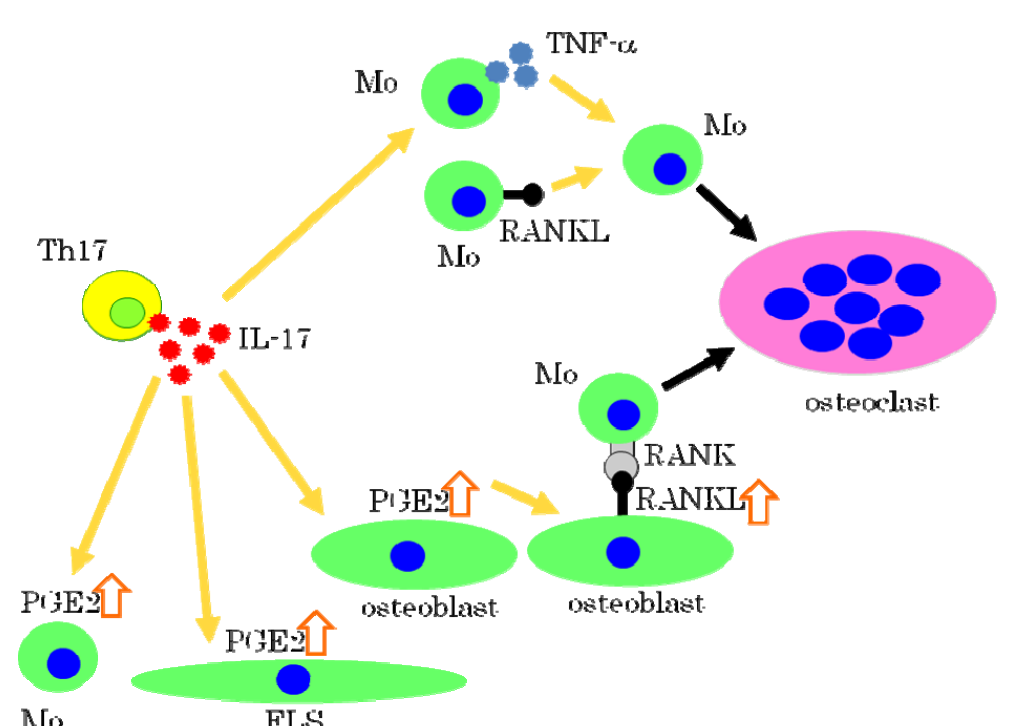
Figure 4. Direct and indirect effects of IL-17 on